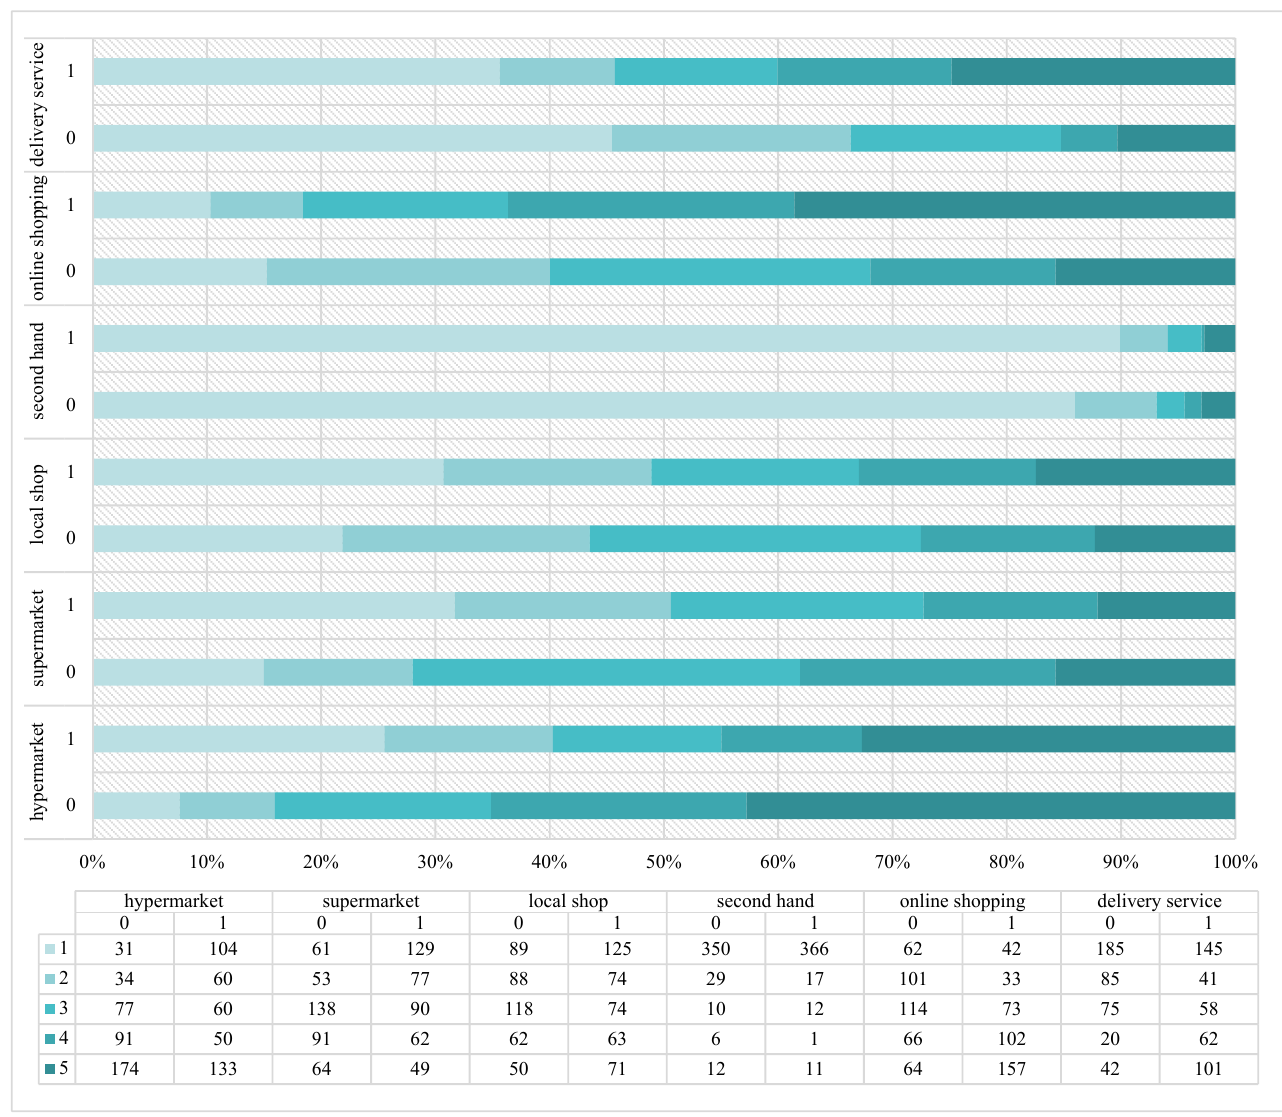
Figure 1. The shopping preferences before and during the COVID-19 pandemic. Before the COVID-19 pandemic (0) and during the COVID-19 pandemic (1) on the horizontal axis. Legend: least used mode of transport (1), previously used mode of transport (2), neither nor (3) previously used mode of transport (4), and the most used mode of transport (5) on the vertical axis.